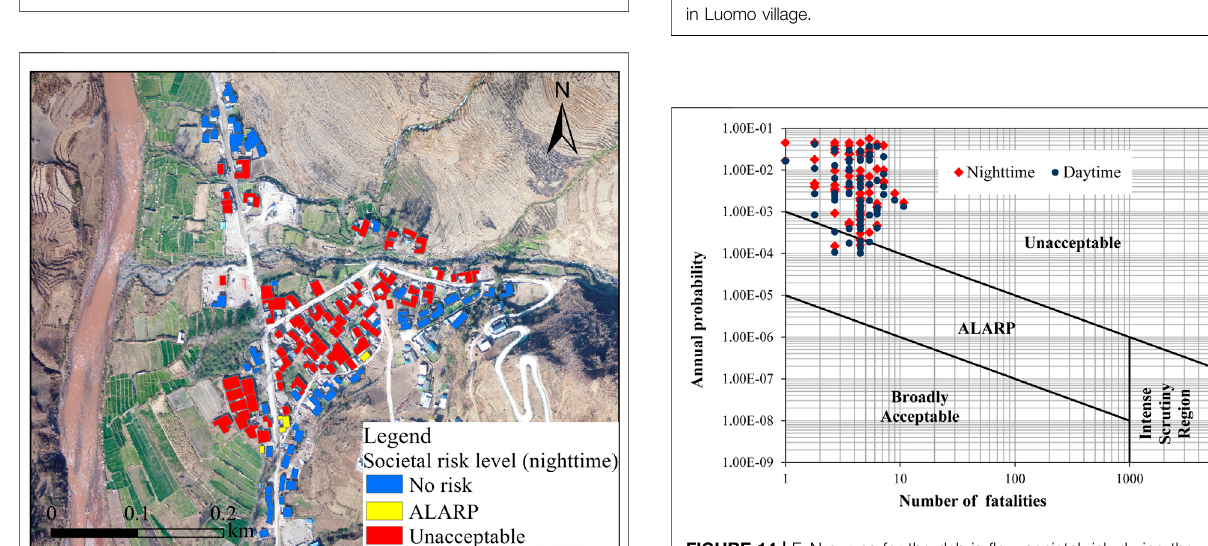
FIGURE 11 | Societal risk map during the daytime in Luomo